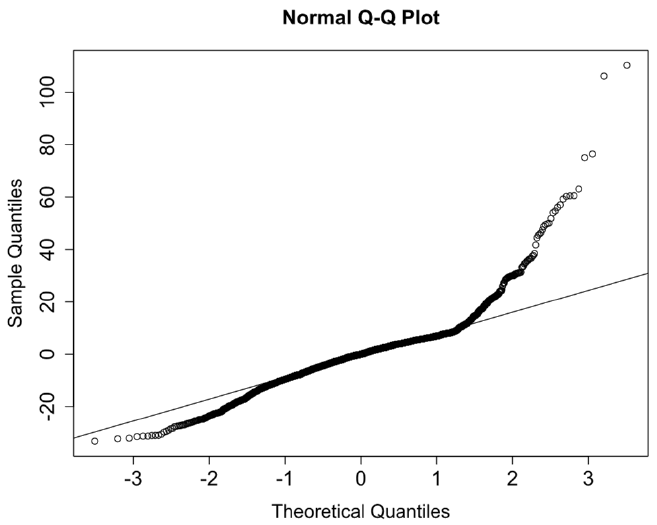
Figure 7. Q-Q Figure 7. Q-Q plot.